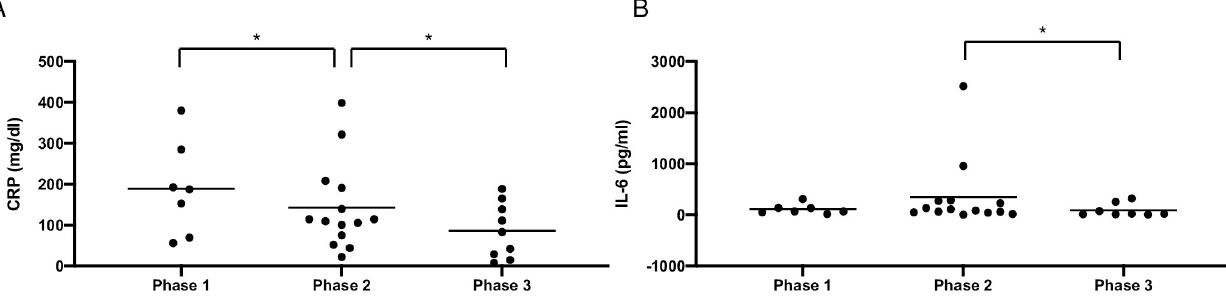
Fig 5. C reactive protein (CRP) (A) and interleukin-6 (IL-6) (B) of peripheral blood of COVID-19 patients with pulmonary HSV-1 reactivation represented in 3 phases (phase 1: day 1–10, phase 2: day 11–30 and phase 3: day 31–40) starting at symptom onset. ( � p < 0.05).